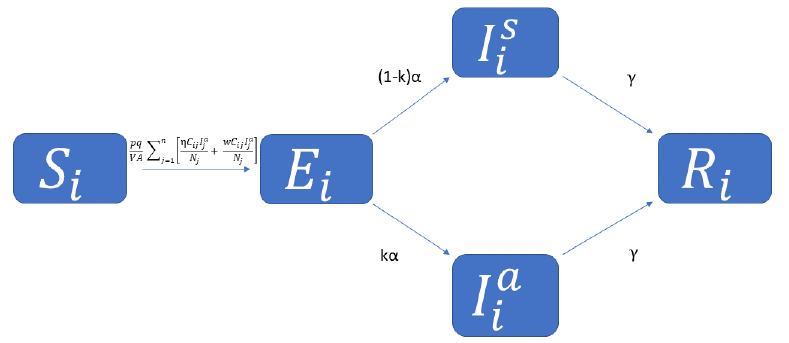
Figure 2. Combined Model